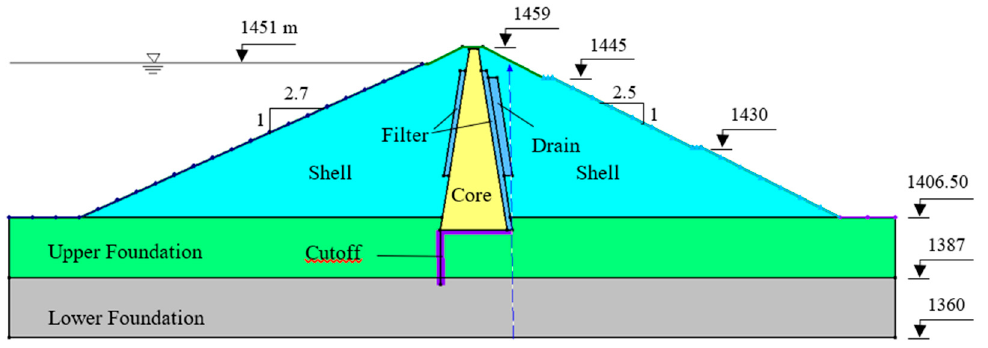
Figure 2. Dam components.